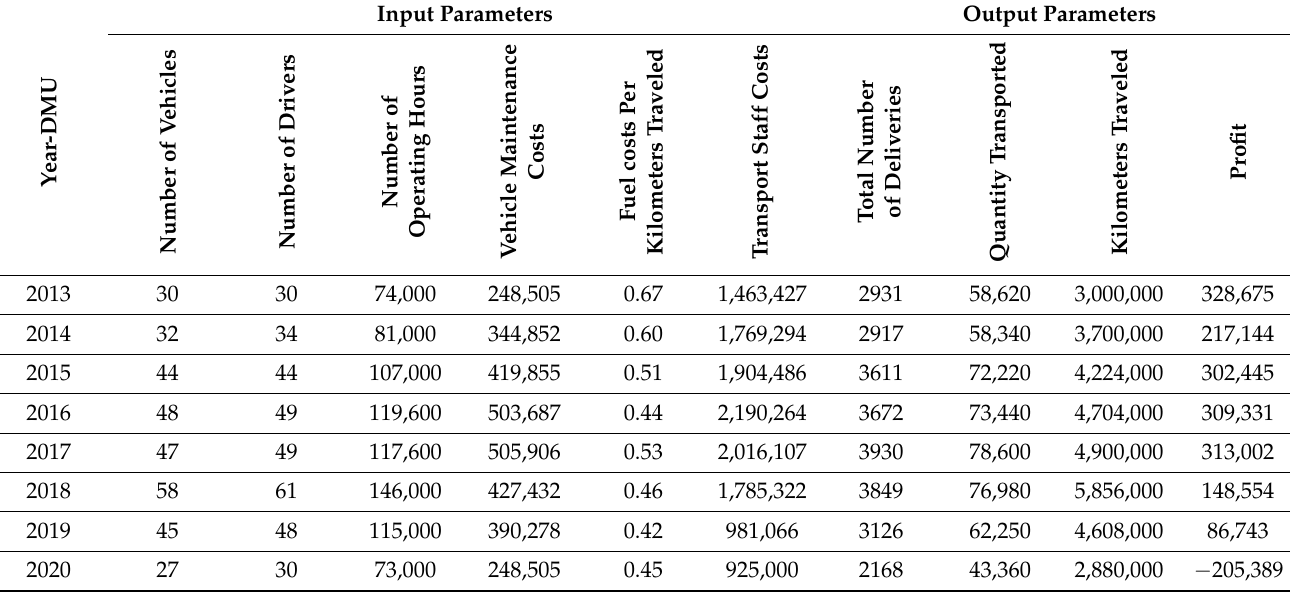
Table 2. Input and output parameters of company TC1.